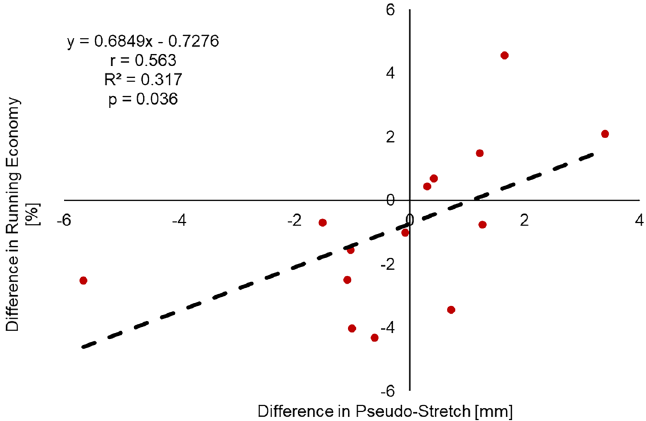
Figure 2. Difference in performance versus difference in pseudo-stretch (red) and trendline for all fourteen participants (black). Positive values for difference in pseudo-stretch and difference in performance indicate a greater stretch and better performance respectively in the stiff shoe